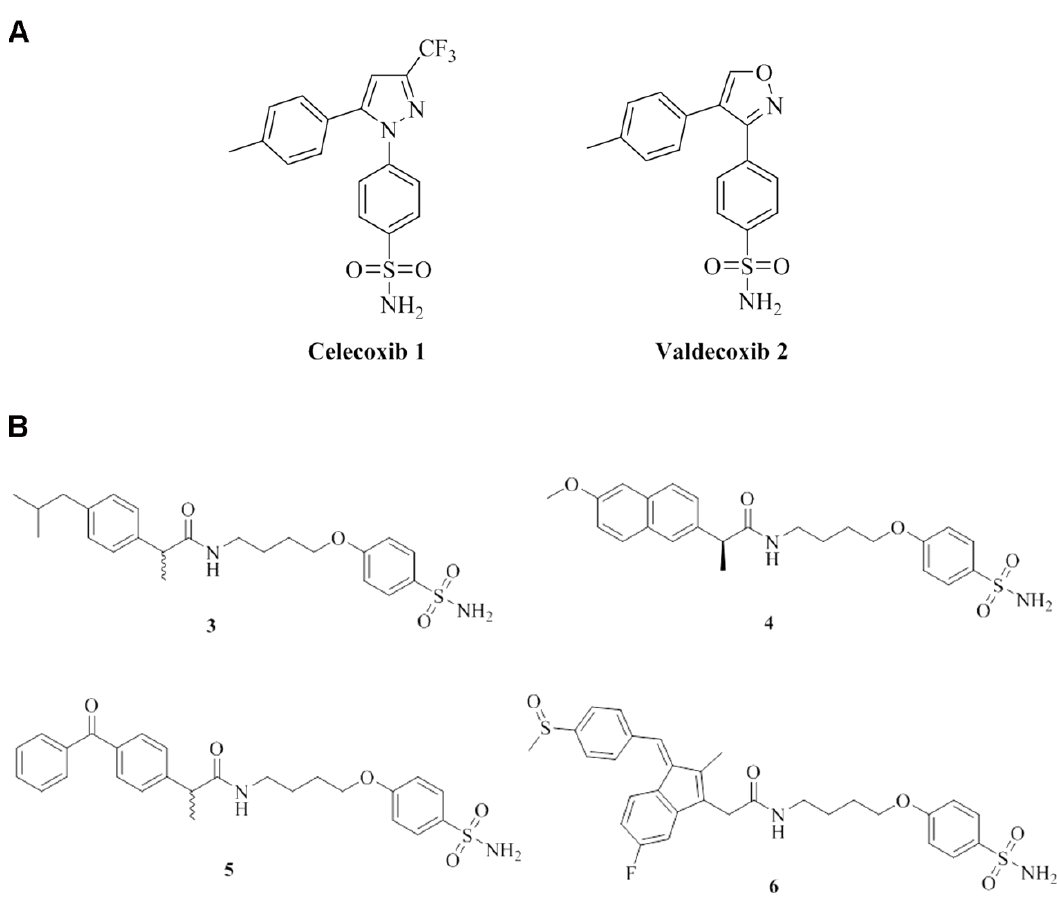
Figure 1. Chemical structures. ( A ) celecoxib 1 and valdecoxib 2. ( B ) chemical structures and molecular weights of the studied compounds 3 – 6 [7].